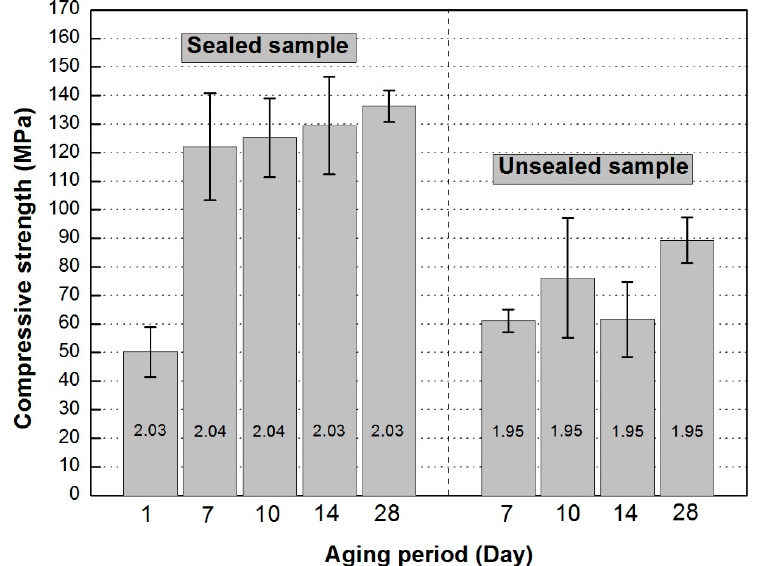
Figure 4. Compressive strength of geopolymers of the sealed “A” series specimens and the unsealed “B” series specimens. “A” series specimens in sealed moulds presented higher compressive strength at testing periods. Numbers in the bars are the apparent density (g/cm 3 ).